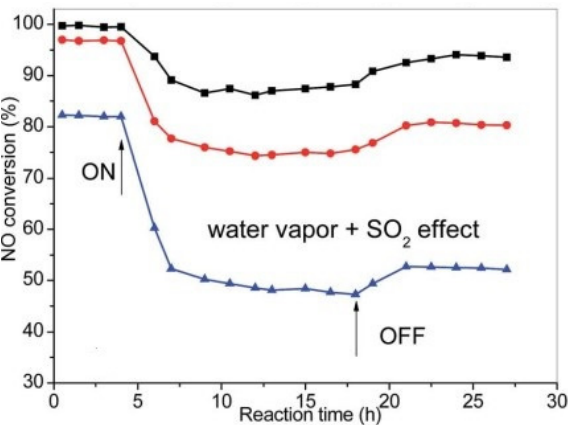
Figure 32. Effect of water vapor and SO 2 on NO conversion over the MnO x /3DOMC (black), MnO x /NAC (red), and MnO x /TiO 2 (blue) catalysts (Reaction conditions: 190 °C, 1000 ppm of NO, 1000 ppm of NH 3 , 5% of O 2 , 5% of water vapor, and/or 200 ppm of SO 2 , He balance). (Reproduced with permission from Reference [54] Copyright 2015, The Royal Society of Chemistry.).